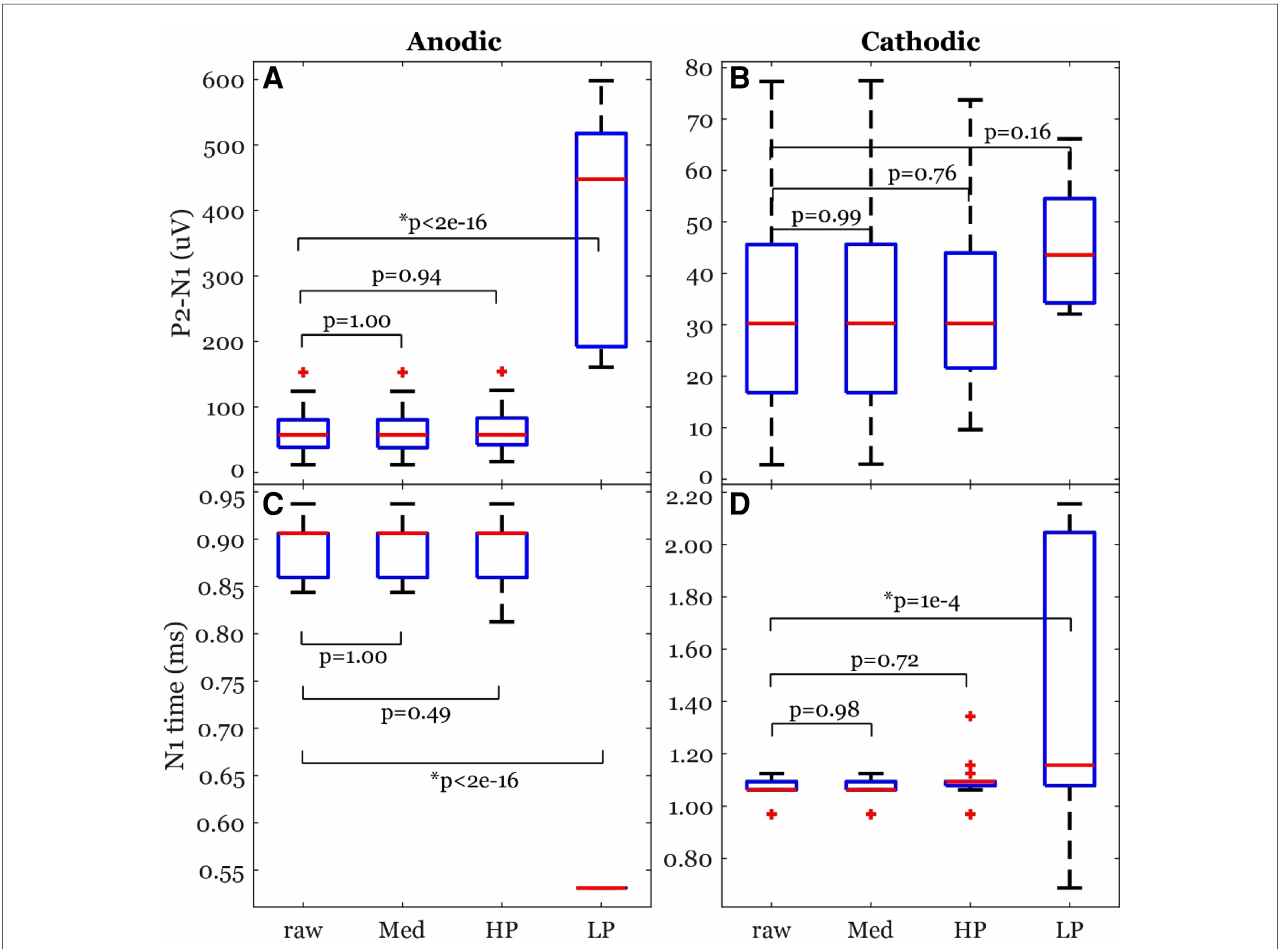
FIGURE 8 Common ECAP characteristics: ( A,B ) peak-valley amplitude (P2-N1) and ( C,D ) N1 time; across the four fi ltering options; raw: no fi ltering, Med: median fi lter, HP: high pass fi lter, and LP: low pass fi lter. The p -values come from a linear model. The data included 20 observations from two participants with stimulation amplitudes suf fi cient to evoke ECAP in each